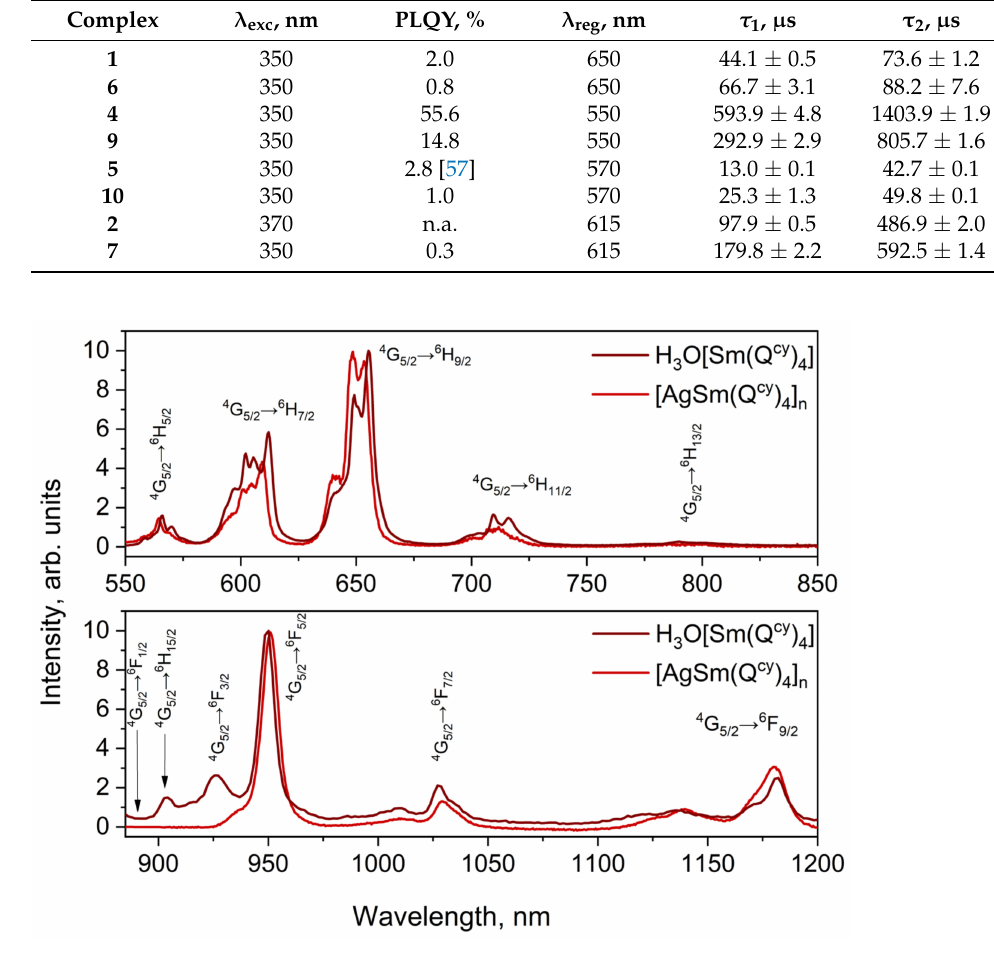
Figure 7. Photoluminescence spectra of Sm 3+ complexes 1 and 6 .